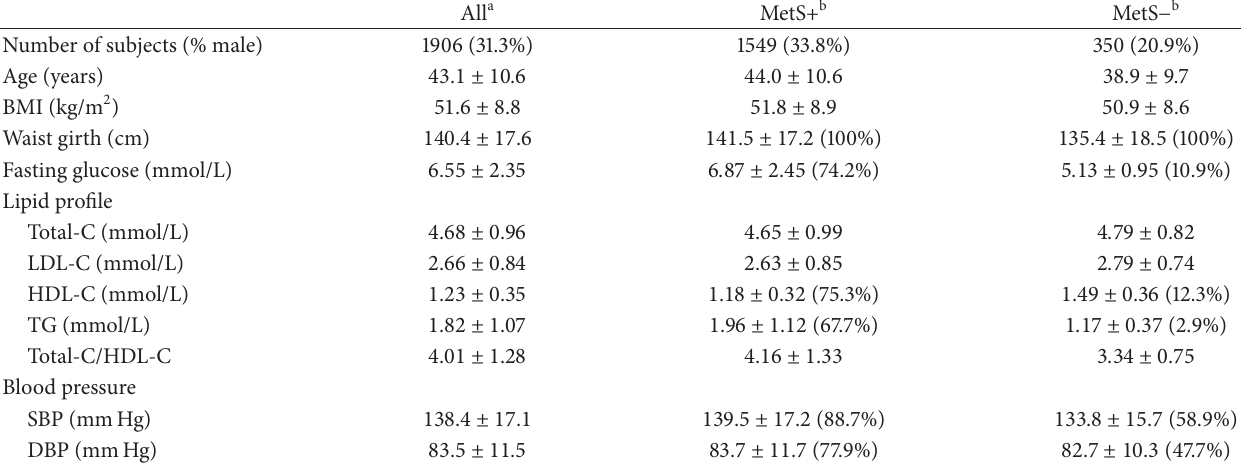
Table 1: Subjects’ characteristics.